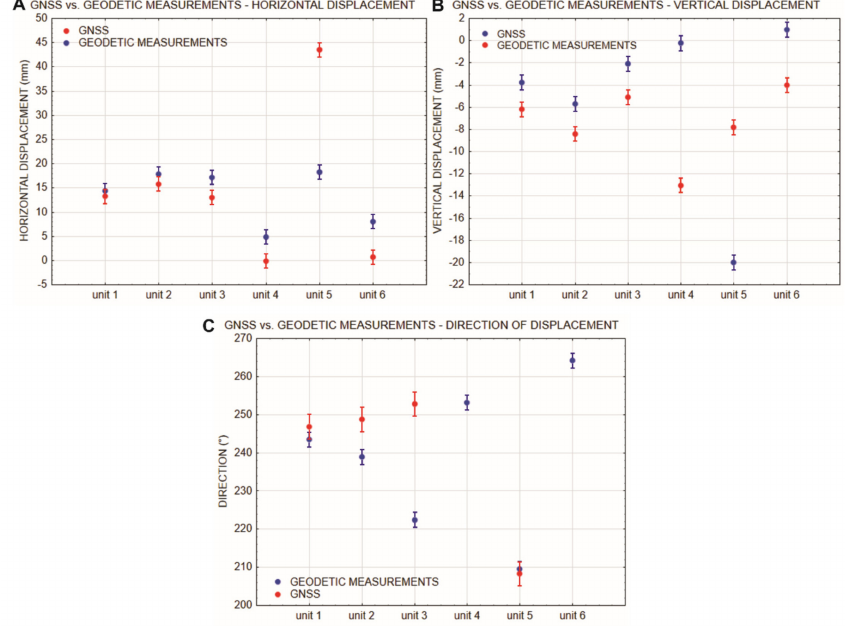
Figure 8. Horizontal and vertical displacements, and direction of the displacement measured by GNSS at the units and geodetic measurements at the closest geodetic